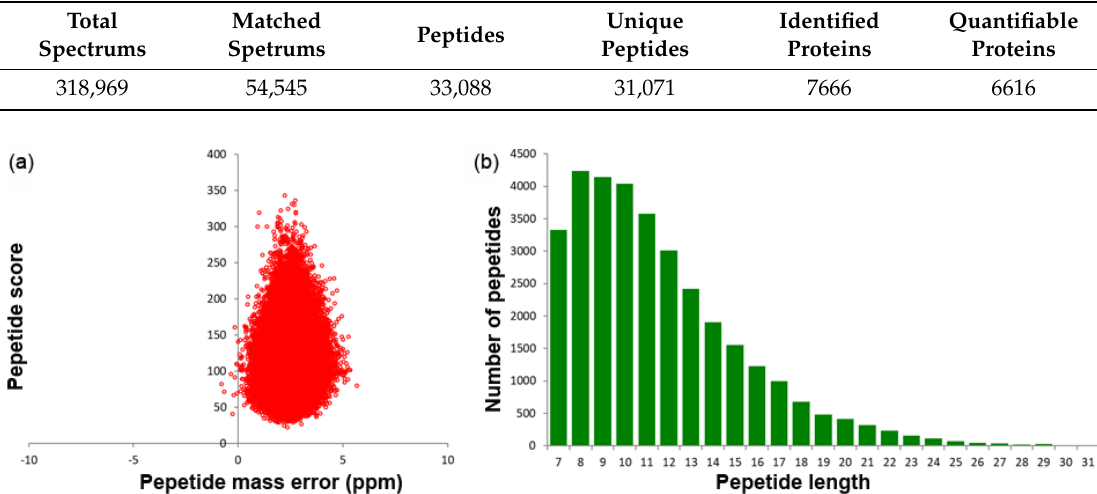
Figure 1. MS identified information based on proteomics analysis: ( a ) Average peptide mass error; ( b ) All identified peptides length distribution.